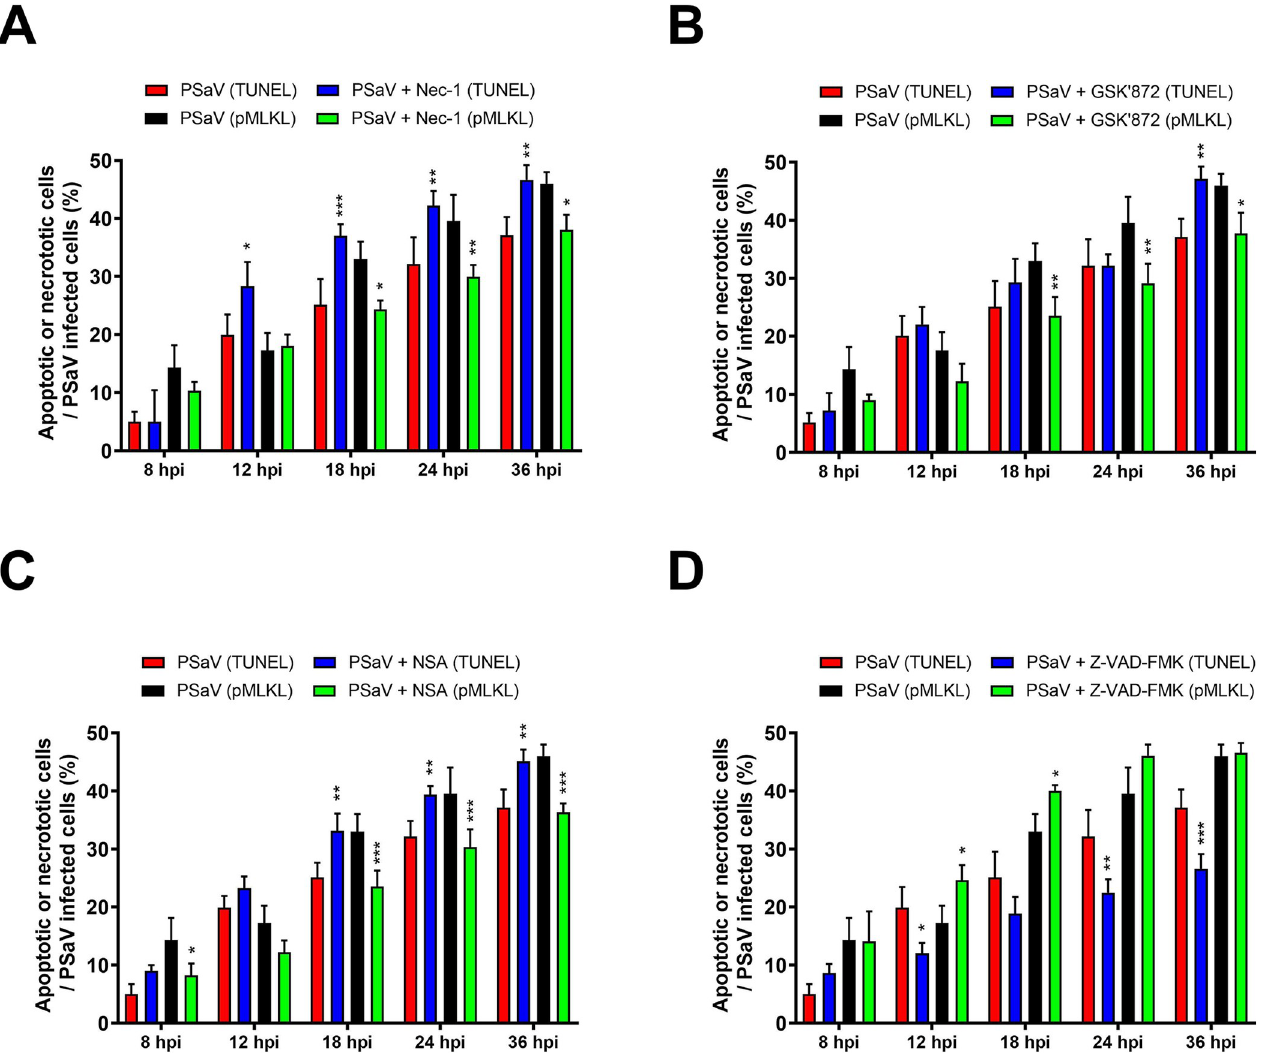
Fig 9. Inhibition of necroptosis converted PSaV-induced cell death into apoptosis and vice versa. (A-D) LLC-PK cells were infected with PSaV Cowden strain (MOI = 1 TCID 50 ), treated with 30 μ M Nec-1 (A), 10 μ M GSK’872 (B), 10 μ M NSA (C), or 20 μ M Z-VAD-FMK (D) or left mock-treated and then harvested at the indicated time points. Quantification of the number of LLC-PK cells positive for both viral VPg antigen and necroptosis molecule pMLKL or for both viral VPg antigen and apoptotic TUNEL signal were analyzed by flow cytometry. The data are shown as the percentage of necrotic or apoptotic LLC-PK cells infected with PSaV in the absence or presence of each chemical. All experiments were performed in triplicate and the data represent the means ± standard errors of the mean. Differences were evaluated using two - way ANOVA. � p < 0.05; �� p < 0.01; ��� p < 0.001.